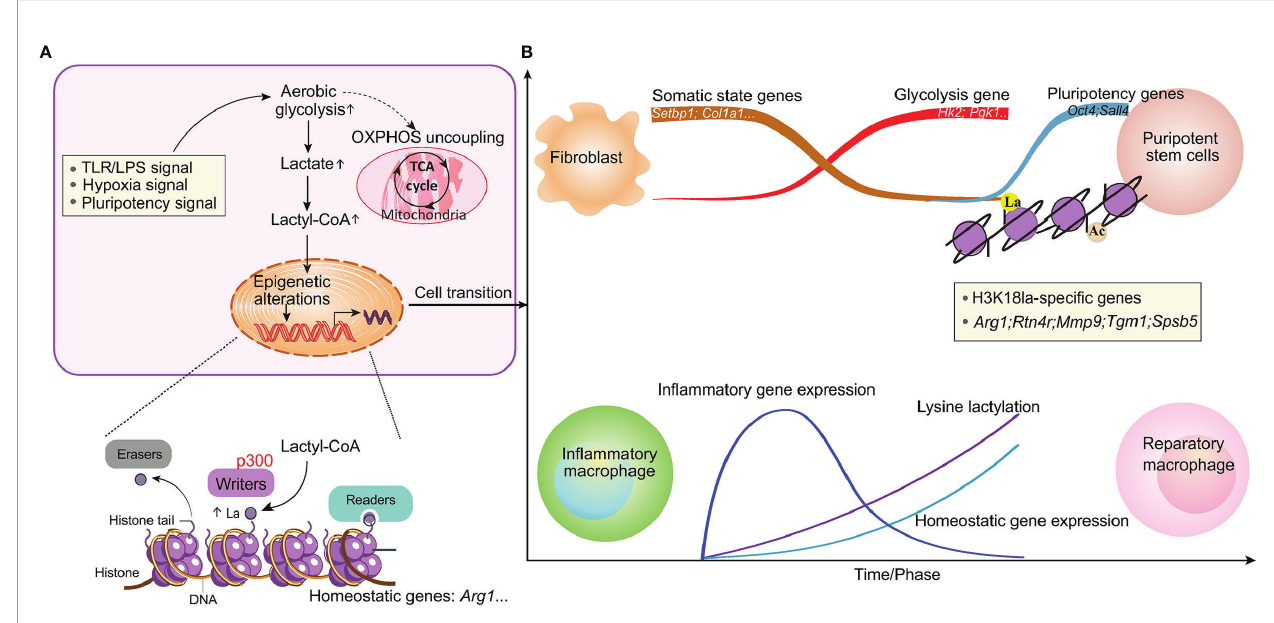
FIGURE 2 | Lactate-induced epigenetic alterations that shape the cellular phenotype. (A) Stimuli that activate glycolysis and induce metabolic rewiring can induce epigenetic remodeling through histone modi fi cations, thereby resulting in cellular fate decisions. The enzymes that catalyze the production of the intermediate molecule lactyl-CoA, from which histone lactylation is derived, and those that deposit (writers), remove (erasers) or recognize and interpret (readers) histone lactylation remain to be elucidated. (B) An increase in lysine lactylation is delayed after macrophage polarization or somatic cell reprogramming. This delay correlates with changes in the expression of homeostatic genes involved in maintaining biological homeostasis but not with changes in in fl ammatory gene expression. Lactylation generates a lactate clock to restore normal tissue function after